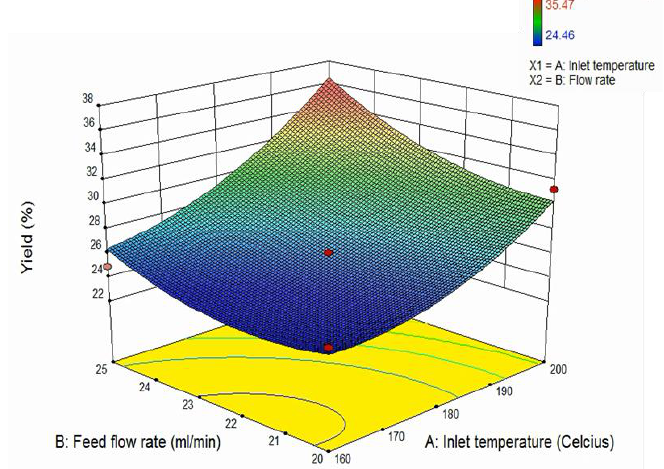
Figure 1. Three-dimensional surface plot of the effect of inlet temperature and feed flow rate to the powder yield.